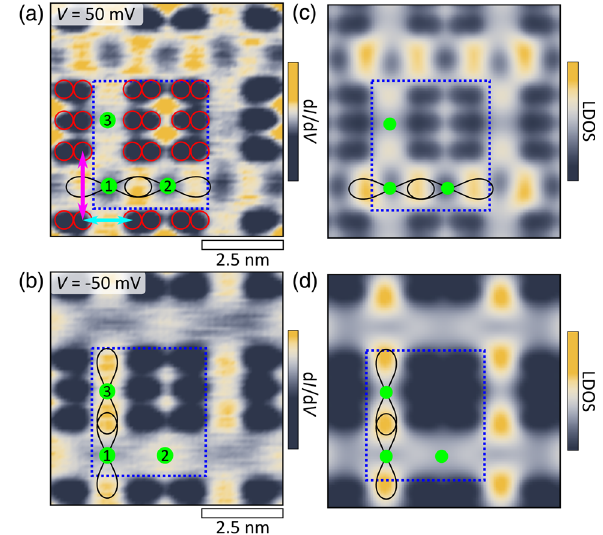
FIG. 3. (a),(b) Differential-conductance maps acquired at V ¼ þ 50 mV and V ¼ − 50 mV, respectively, above an asym- metric Lieb-like lattice with more spacing in the y direction (pink arrow) than in the x direction (cyan arrow). A part of the lattice is shown. The maps were acquired after stabilization at I V ¼ þ 50 and − 50 mV, respectively, with a bias modulation set V ¼ 5 mV. (c),(d) Same as (a),(b), calculated using the rms muffin-tin